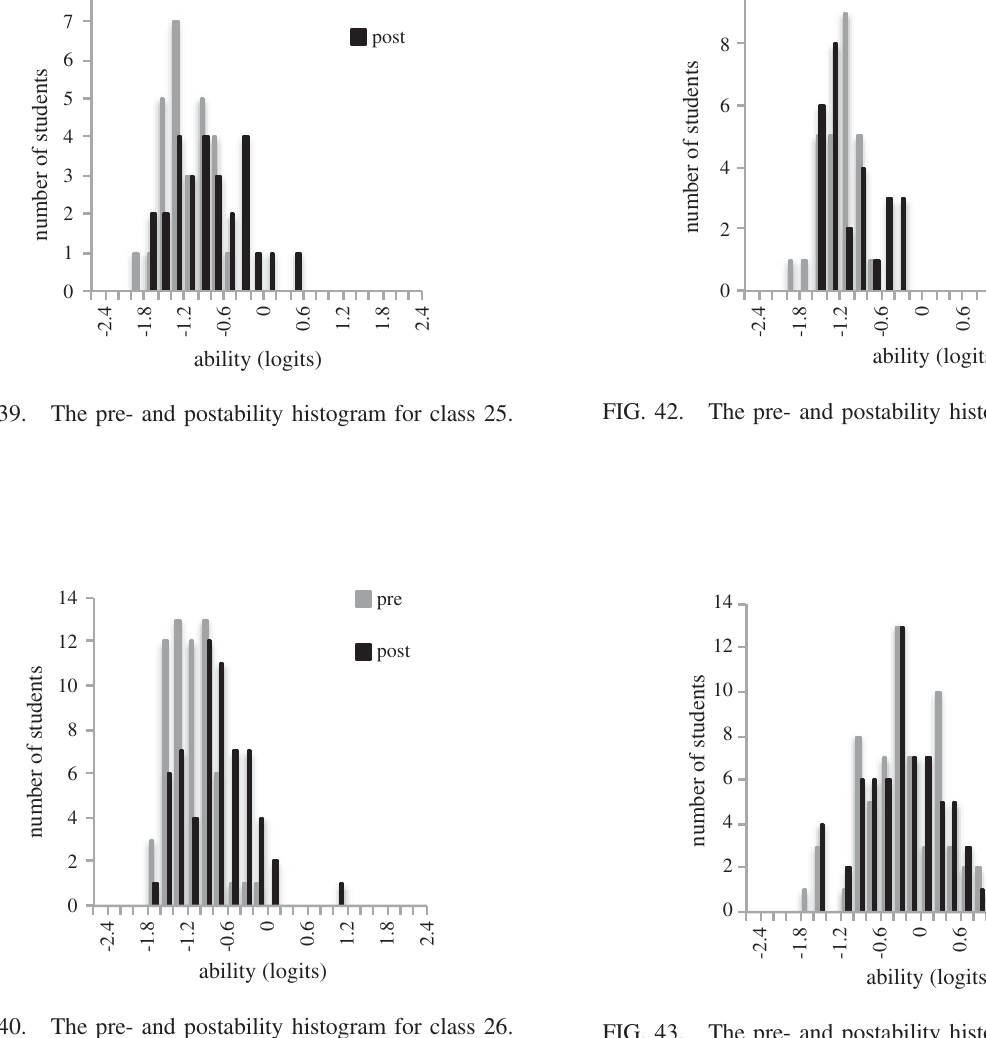
FIG. 43. The pre- and postability histogram for class